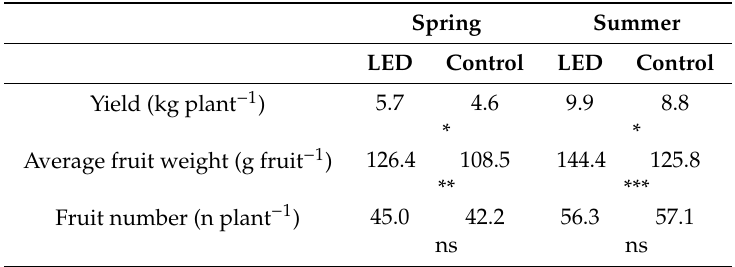
Figure 6. E ff ect of supplemental LED interlighting ( a , c ) and control treatment ( b , d ) on fruit growth / maturation stage during spring ( a , b ) and summer ( c , d ) season. Table 3. E ff ect of lighting regime on plant productivity, fruit average weight, and fruit number during Figure 6. Effect of supplemental LED interlighting ( a and c ) and control treatment ( b and d ) on fruit spring and summer growth/maturation stage during spring ( a and b ) and summer ( c and d ) season.